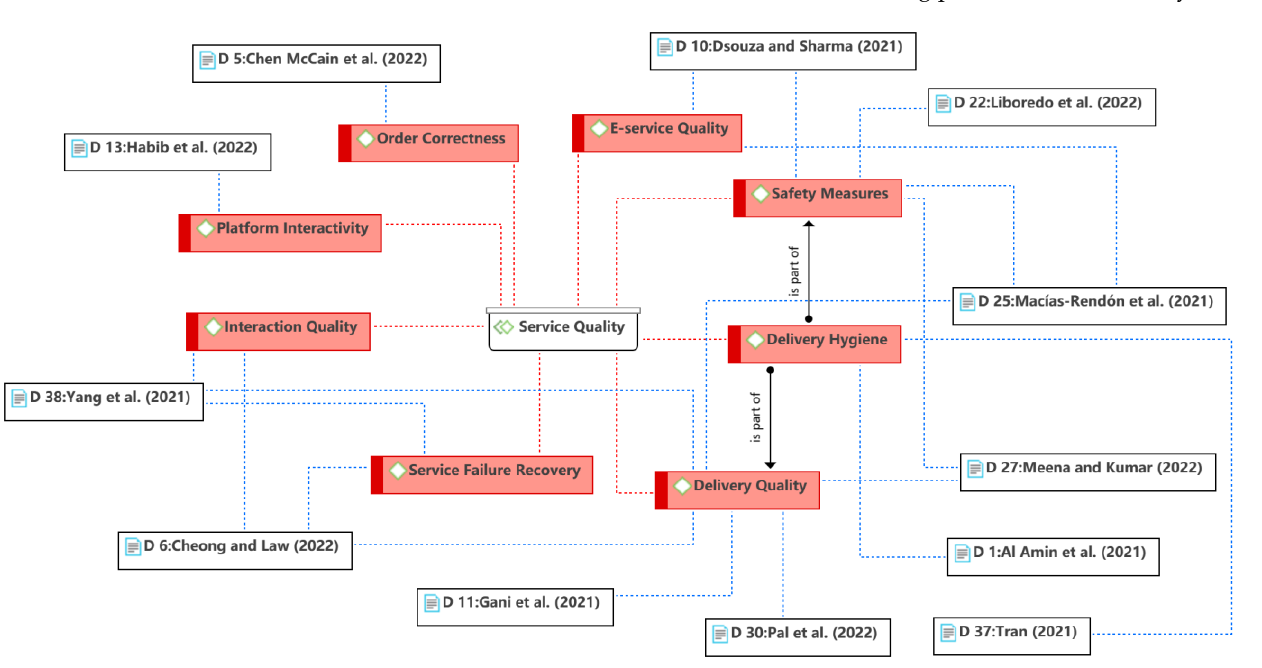
Figure 9. Theme 5: service quality [9,12,14,24,27,40,41,43,47 – 49,61].